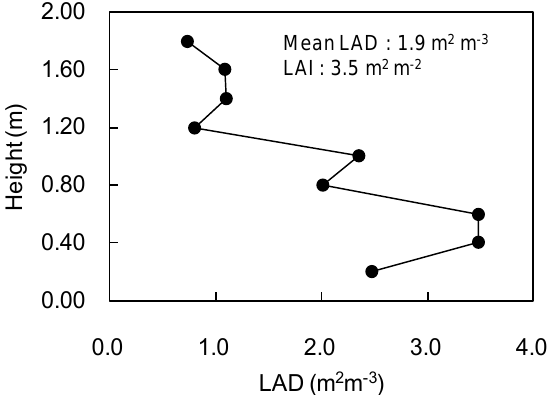
Figure 6. Vertical LAD profile of the tomato canopy estimated from lidar-derived leaf areas.